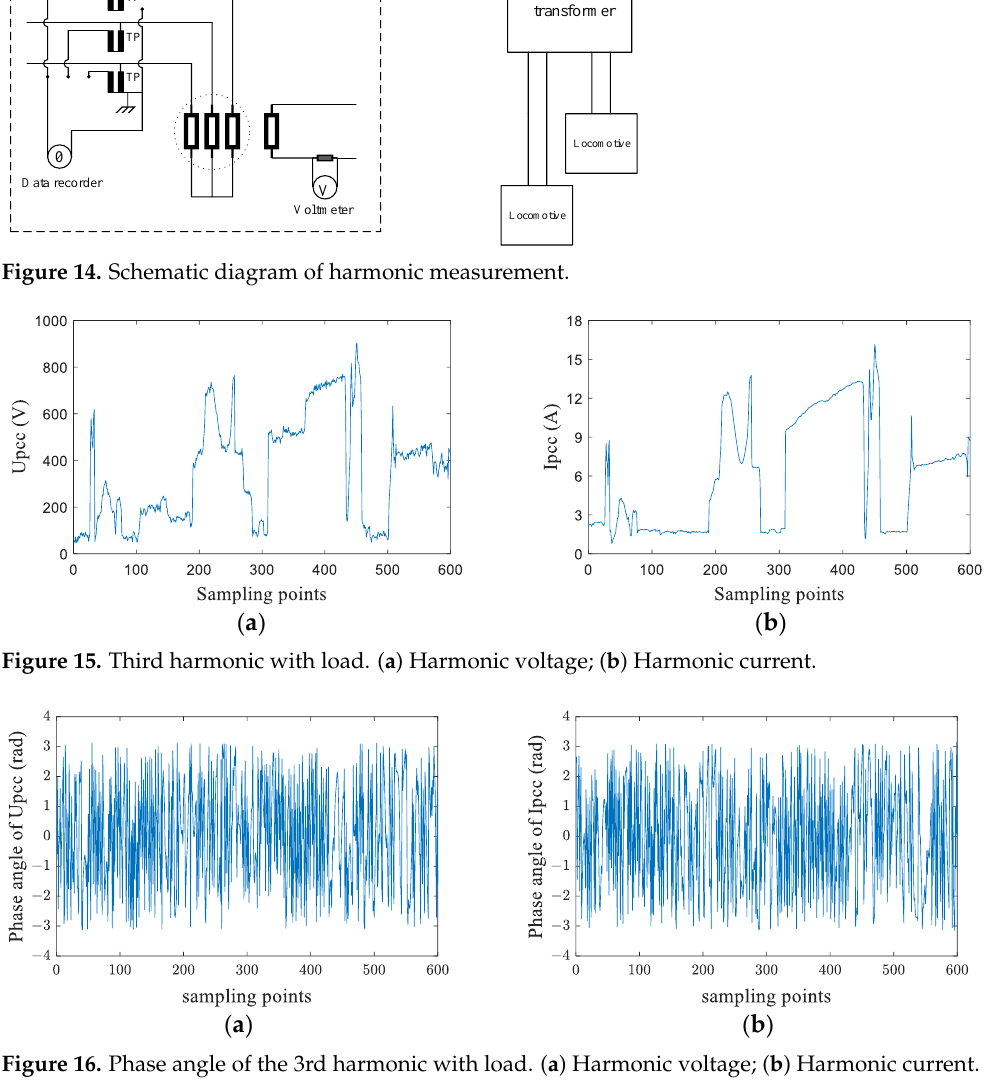
Figure 16. Phase angle of the 3rd harmonic with load. ( a ) Harmonic voltage; ( b ) Harmonic current.